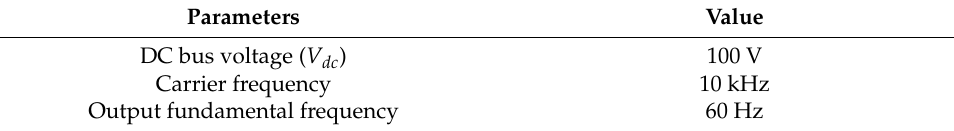
( b ) Figure 10. Two ‐ level converter test system: ( a ) system block diagram; ( b ) testing platform.